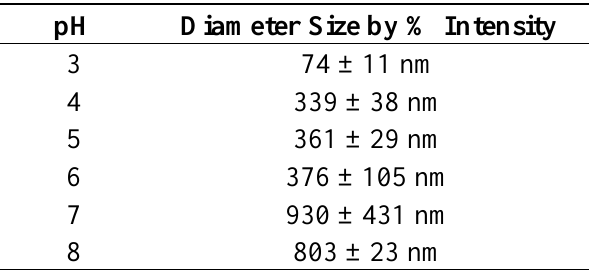
Table 3. Average particle size of agglomerates formed in methanol synthesis at various pH.